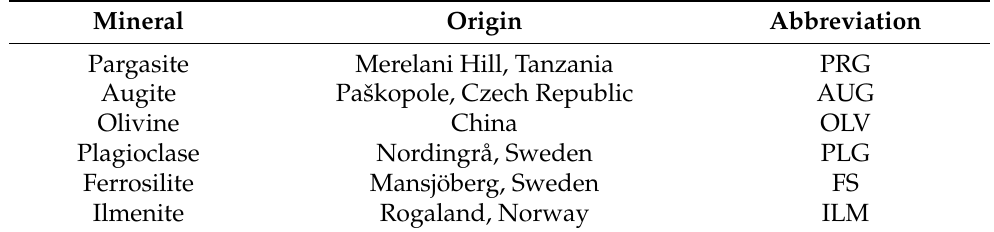
Table A6. Origins of endmember catalog for Section 3.2 taken from Rommel et al. [13]. All samples were provided by the University of Göttingen and originate from Earth.